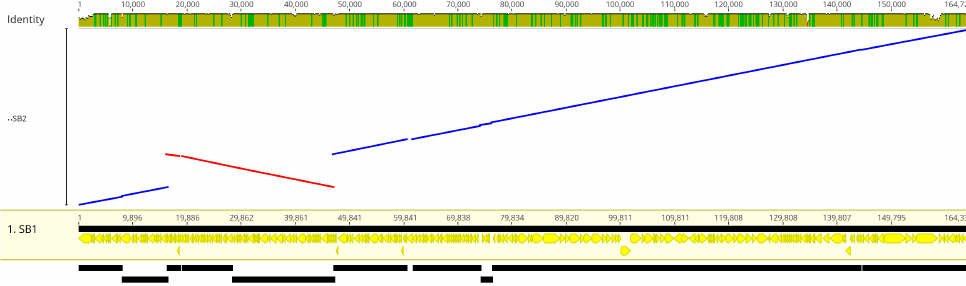
Figure 11. LASTZ alignment of the DLP2 forward (blue) and reverse (red) genome against DLP1. The DLP2 alignment shows a 31 kb inversion compared to DLP1. The inverted section of DLP2 encodes genome replication and modification genes.